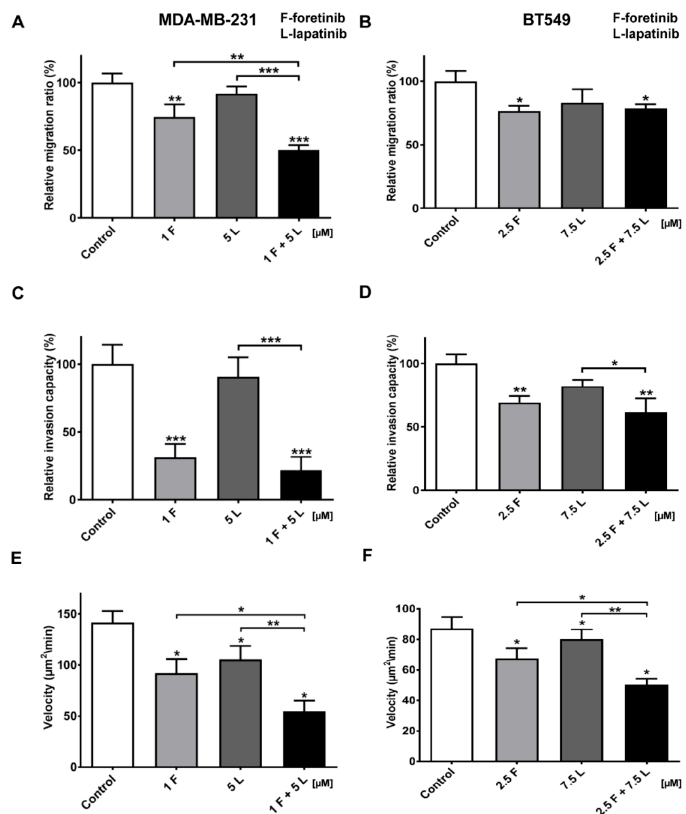
Figure 6. Migration and invasion capacities and invasion velocity of TNBC cells treated with MET and EGFR inhibitors. ( A , C , E ) MDA-MB-231 and ( B , D , F ) BT549 cells were incubated with foretinib (F) lapatinib (L), or their combination at the indicated concentrations ( µ M) for 24 h or 48 h. ( A , B ) Migration and ( C , D ) invasion experiments were conducted on Transwell filters, non-coated (migration), or coated with collagen type I (invasion). Results are expressed as the mean ± SD and are based on at least three independent experiments. Migration and invasion capacity in control cells is set to 100%. ( E , F ) Invasion velocity of control and treated cells. The change in area of the cell layer was continuously measured and the mean velocity derived from the area increase in time and was calculated ( n = 8). The error bars represent SD. For all graphs, asterisks indicate conditions statistically significant, which is different from the control. The significance level was set at p ≤ 0.05 (*), p ≤ 0.01 (**), or p ≤ 0.001